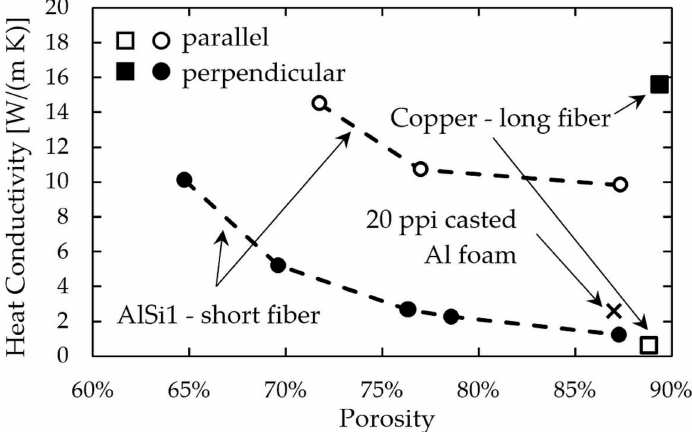
Figure 8. Heat conductivity of metal fiber structures in the two major directions (parallel and perpendicular to isotropic plane) and heat conductivity of an aluminum